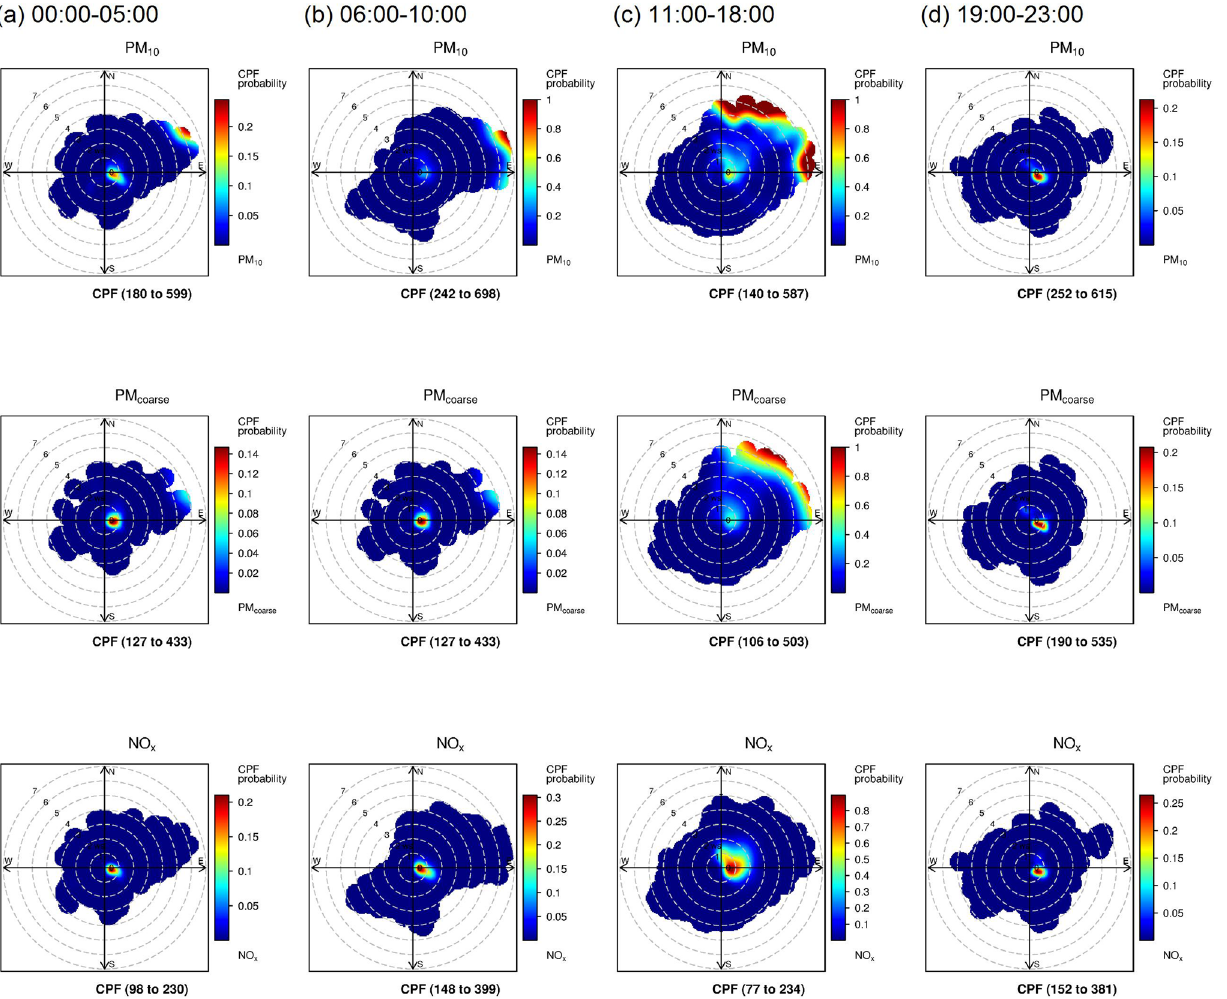
Figure 7. CBPF plot of PM 10 , PM coarse , NO x concentrations for 91–100 percentile range at four periods ( a ) 00:00–05:00, ( b ) 06:00–10:00, ( c ) 11:00–18:00, ( d ) 19:00–23:00. (Range in the bracket is the concentration range in a unit of µg/m 3 and ppb for PM and NO x ,